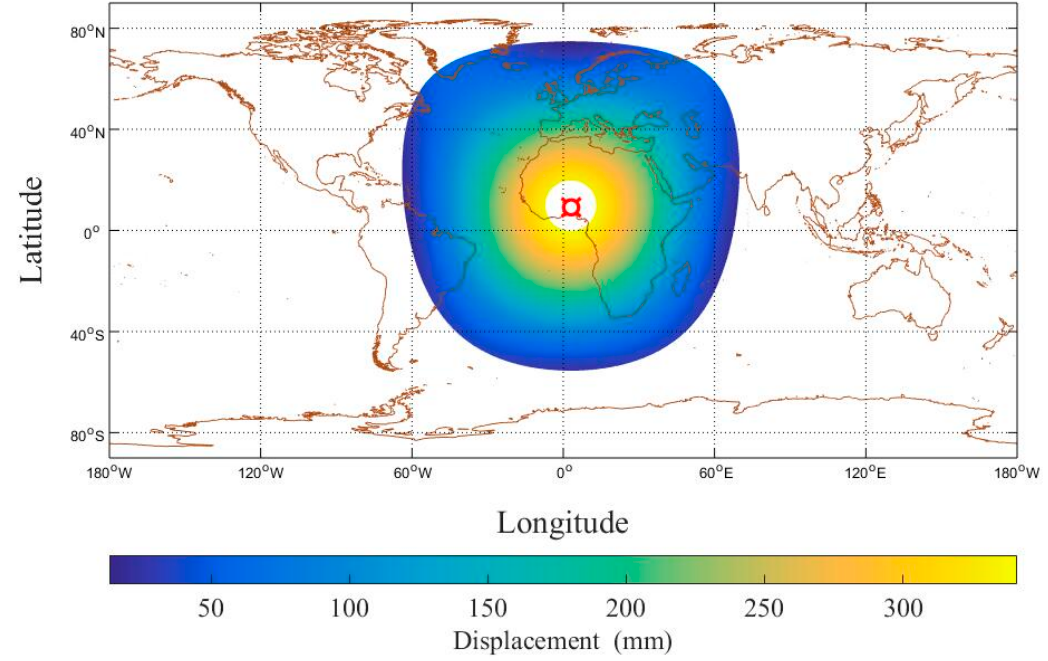
Figure 7. Global displacement distribution in moon direction with incident angle constraint of 10–66 ° at 0:00 on 2 March 2018.